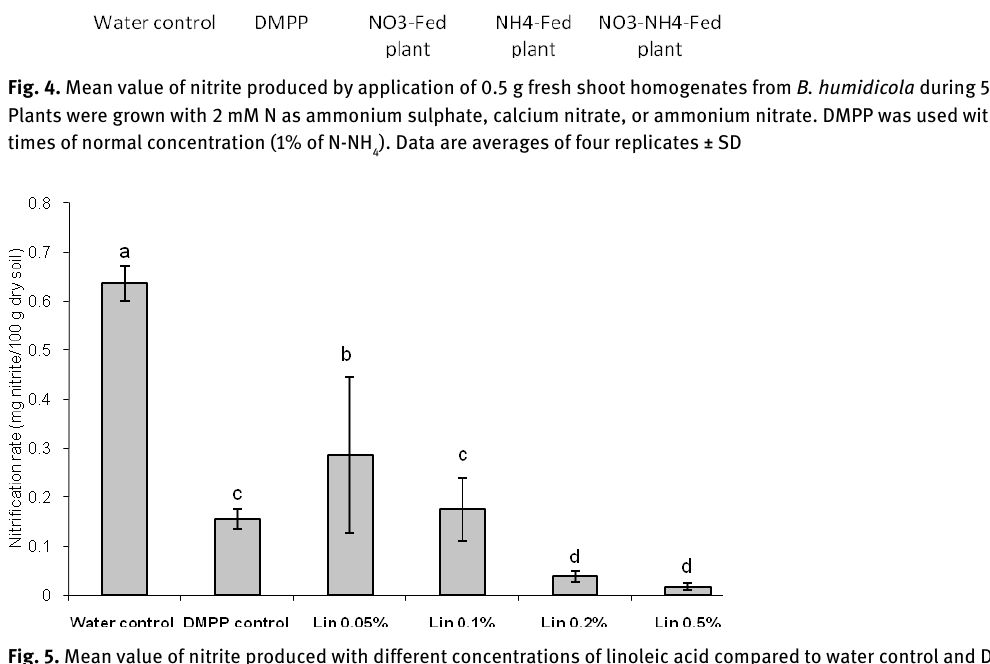
Fig. 5. Mean value of nitrite produced with different concentrations of linoleic acid compared to water control and DMPP control (10% of N-NH 4+ ) in a 24 h incubation period. Linoleic acid was used in 0.05, 0.1, 0.2 and 0.5 percent equals to 5, 10, 20 and 50 µl per sample. Compa- rison of means was done at 5% of Duncan test. Data are the averages of four replicates ± SD